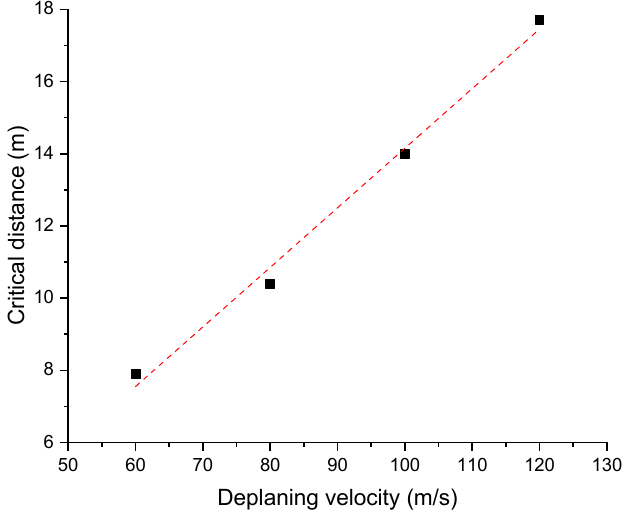
Figure 13. Critical distances between parachute systems at different deplaning velocities.